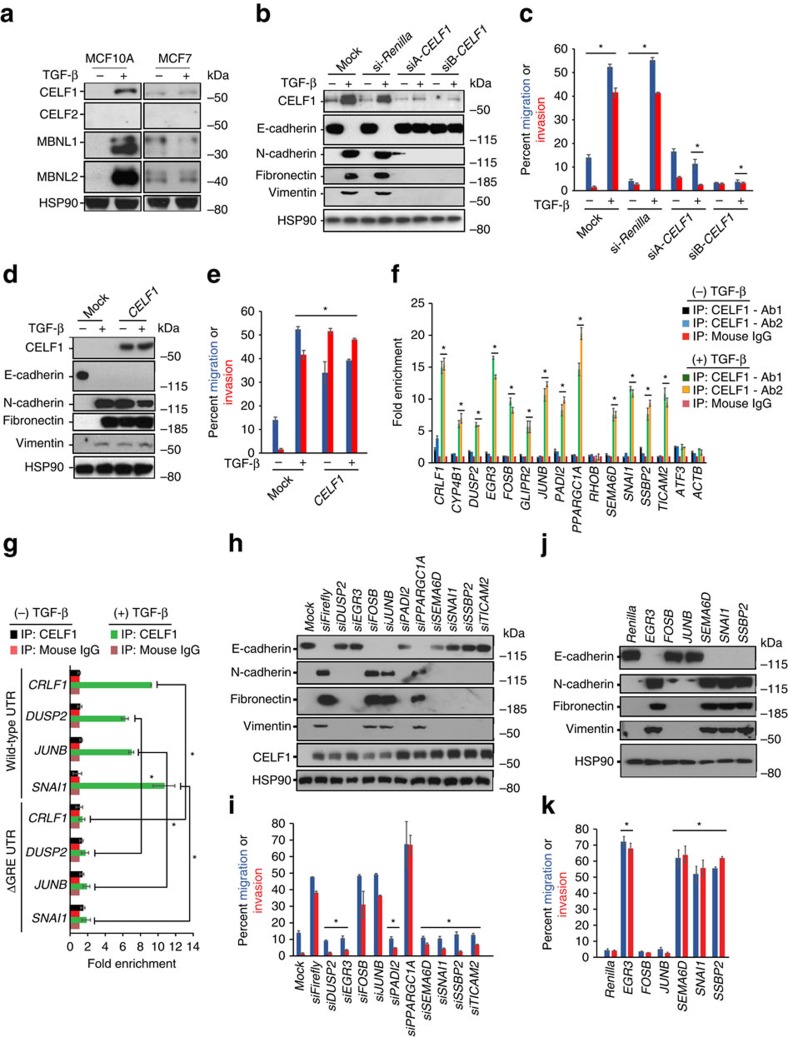
CELF1 is a major regulator of GRE-containing mRNAs encoding drivers of EMT.(a) Immunoblot analysis of CELF and MBNL proteins in untreated and TGF-β-treated MCF7 and MCF10A cells. HSP90 serves as a loading control. (b) Immunoblot analysis of epithelial and mesenchymal markers in untreated and TGF-β-treated MCF10A cells transiently transfected with the indicated siRNAs. HSP90 serves as a loading control. (c) Quantification of relative cellular migration and invasion in transwell assays in untreated and TGF-β-treated MCF10A cells transiently transfected with the indicated siRNAs or overexpression constructs. (d) Immunoblot analysis of epithelial and mesenchymal markers in untreated and TGF-β-treated MCF10A cells transiently transfected with vehicle or CELF1 overexpression construct. HSP90 serves as a loading control. (e) Quantification of relative cellular migration and invasion in transwell assays in untreated and TGF-β-treated MCF10A cells transiently transfected with vehicle or CELF1 overexpression construct. (f) RNA crosslinking-immunoprecipitation/qRT-PCR of GRE-containing mRNAs from untreated and TGF-β-treated MCF10A cells using two different anti-CELF1 antibodies or mouse IgG. ACTB is a non-GRE-containing negative control. (g) RNA crosslinking-immunoprecipitation/qRT-PCR of tRFP reporters containing either the wild-type 3′-UTRs for the indicated genes or corresponding mutant 3′-UTRs in which the GRE has been deleted by site-directed mutagenesis. Reporters were immunoprecipitated from untreated and TGF-β-treated MCF10A cells using anti-CELF1 antibody or mouse IgG. (h) Immunoblot analysis of indicated epithelial and mesenchymal cell markers and CELF1 in untreated MCF10A cells 72 h post-transient transfection with CELF1 driven by the CMV Immediate Early promoter in combination with siRNAs targeting Firefly Luciferase or each of the ten GRE-containing mRNAs. HSP90 serves as a loading control. (i) Quantification of relative cellular migration and invasion in transwell assays in untreated MCF10A cells 72 h post-transient transfection with CELF1 driven by the CMV Immediate Early promoter in combination with siRNAs targeting Firefly Luciferase or each of the ten GRE-containing mRNAs. (j) Immunoblot analysis of indicated epithelial and mesenchymal cell markers and CELF1 in untreated MCF10A cells 72 h post-transient transfection with pL6.3 expression vectors engineered to overexpress Renilla Luciferase or each of the indicated individual GRE-containing coding sequences in combination with siRNA-targeting CELF1. HSP90 serves as a loading control. (k) Quantification of relative cellular migration and invasion in transwell assays (bottom) in untreated MCF10A cells 72 h post-transient transfection with pL6.3 expression vectors engineered to overexpress Renilla Luciferase or each of the indicated individual GRE-containing coding sequences in combination with siRNA-targeting CELF1. All panels are representative of a minimum of three experimental replicates. For immunoblots depicted, samples were derived from the same experiment and gels were processed in parallel. In c,e,i,k, error bars depict s.d. of the mean. In f,g error bars depict s.e.m. *P≤0.05 (Student's t-test). See also Supplementary Fig. 3. Full scans of blots are shown in Supplementary Fig. 10.